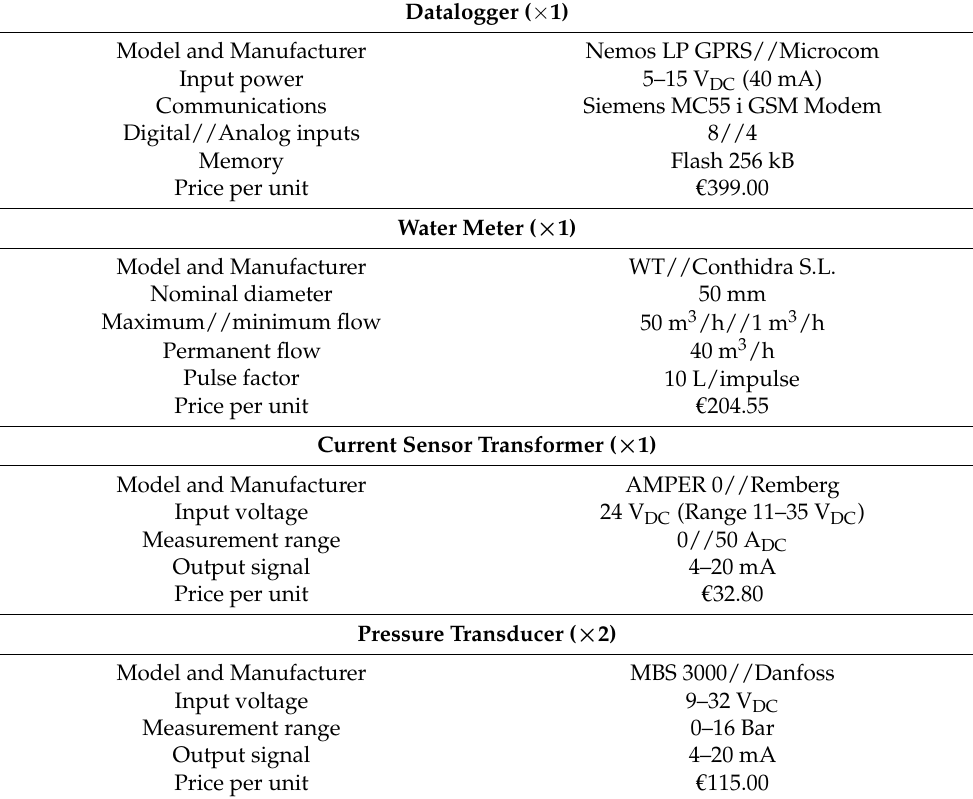
Table 2. Technical parameters and cost of the equipment used for data collection in this